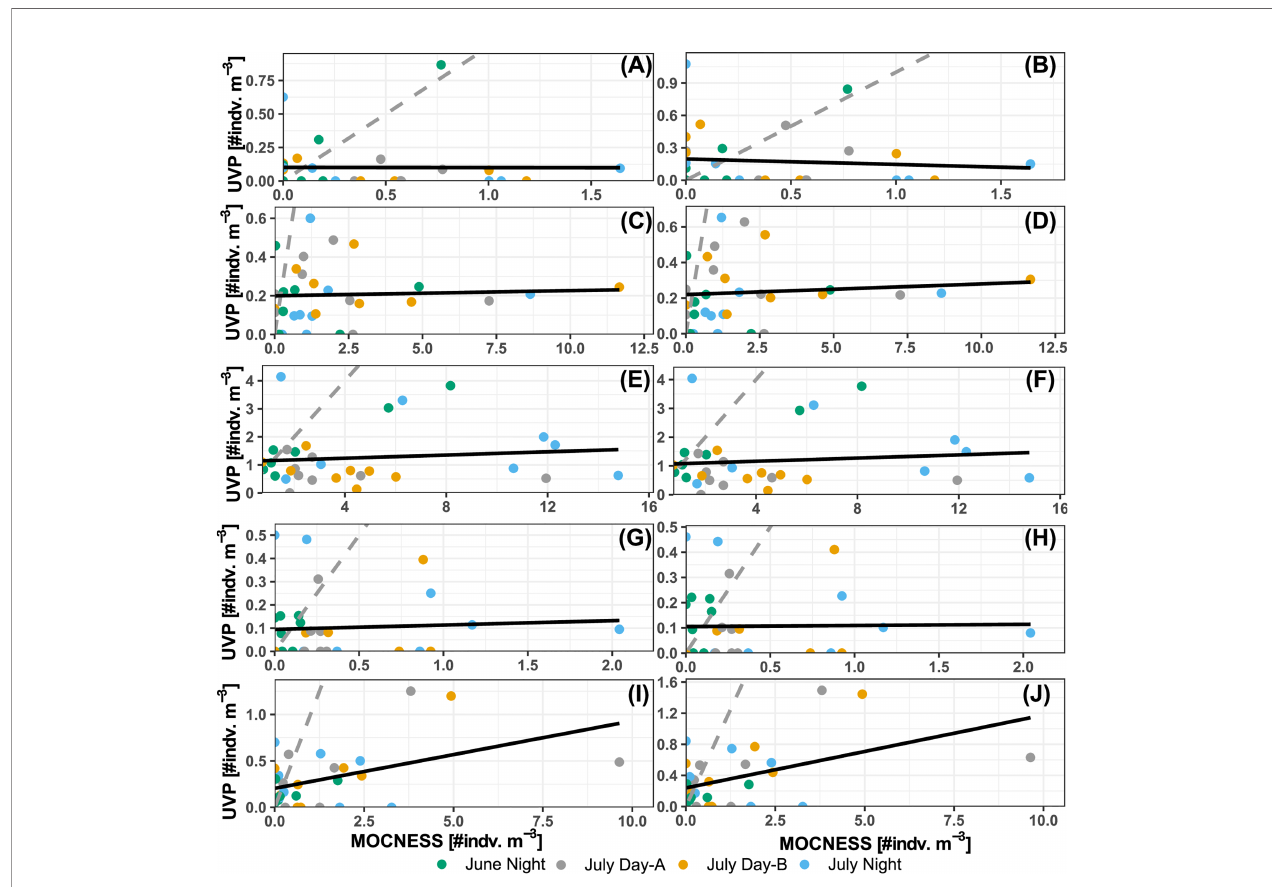
FIGURE 5 | Comparison of MOCNESS density estimates and (A, C, E, G, I) pooled-cast UVP density. Comparison of MOCNESS density estimates and (B, D, F, H, J) average-cast UVP density estimates. Points show density estimates in matching depth bins for (A, B) Annelids, (C, D) chaetognaths, (E, F) copepods, (G, H) shrimp-like crustacean, and (I, J) ostracod/cladocerans. Points are colored by corresponding pro fi le. Dotted line represents the 1:1 line between the two estimates. Solid line shows the line of best fi t identi fi ed through least squares